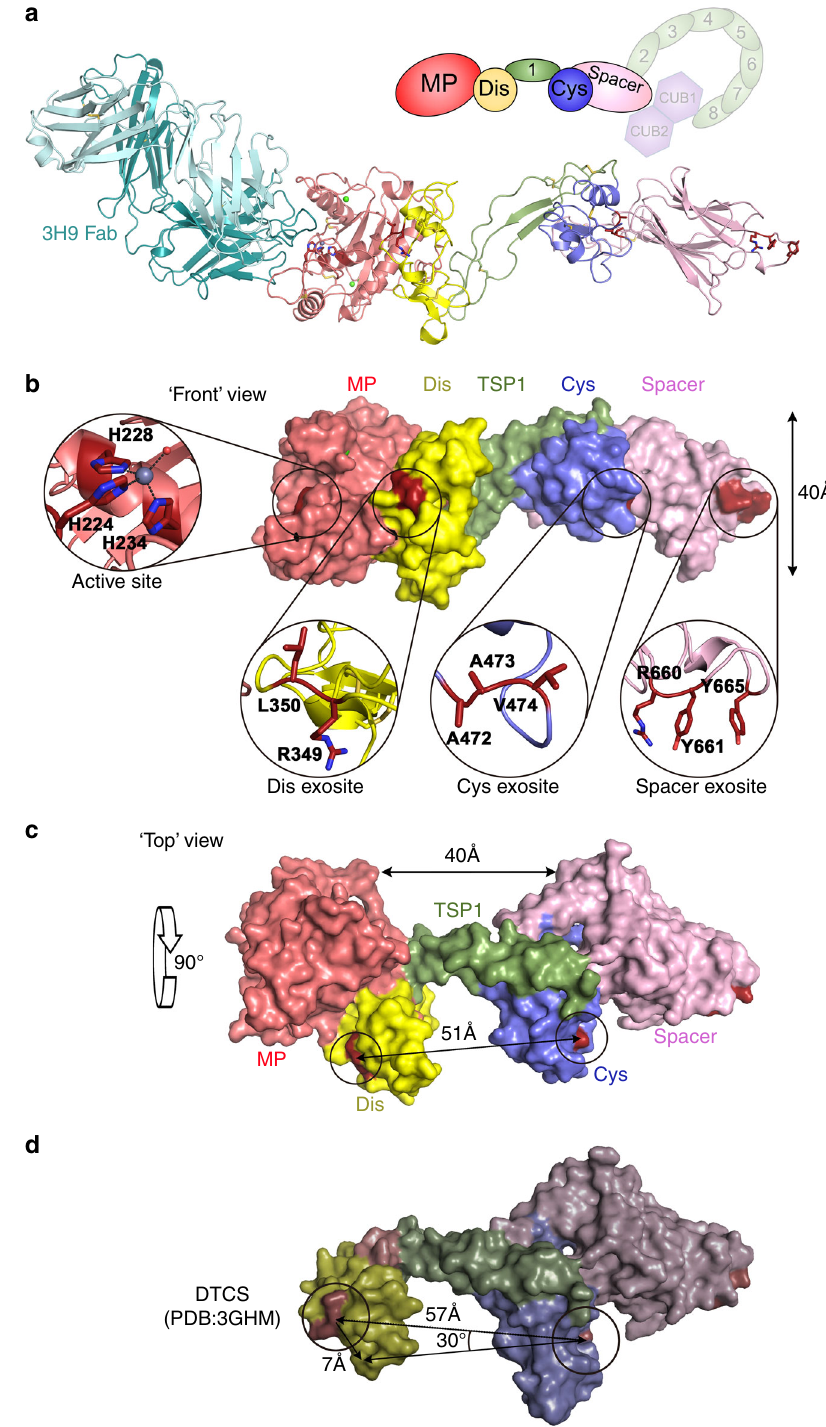
Fig. 4 Crystal structure of 3H9 Fab-MDTCS (MP through to Spacer) complex. a Cartoon representation of ADAMTS13 MDTCS domains bound to the inhibitory 3H9 Fab fragment (teal) (PDB ID: 6QIG). ADAMTS13 domains are labelled and color-coded according to the schematic representation above. b Surface structure of ADAMTS13 MDTCS domains (with the Fab removed) viewed from the “ front ”— substrate-binding face. The ADAMTS13 active-site and exosites are highlighted with residues implicated in the function of each exosite labelled in the insets. Note the linear alignment of the metalloprotease (MP) domain active-site and disintegrin-like (Dis), cysteine (Cys)-rich, and Spacer domain exosites. c Surface structure of ADAMTS13 MDTCS domains (with the Fab removed) viewed from the “ top ”— rotated forward by 90° from b . MDTCS exhibits a butter fl y conformation with the MP and Spacer domains forming “ wings ” separated by 40 Å. The Dis and Cys-rich domain exosites are separated by a distance of 51 Å. d Surface structure of the previously determined DTCS domains (3GHM [https://doi.org/10.2210/pdb3GHM/pdb]). The notable difference between the two structures (apart from the presence/absence of the MP domain) is the location of the Dis and Cys-rich domain exosites, which in our structure is twisted by ~30° and declined by ~7 Å, which reduces the distance between Dis and Cys-rich domain exosites by 6 Å — see Supplementary Movie